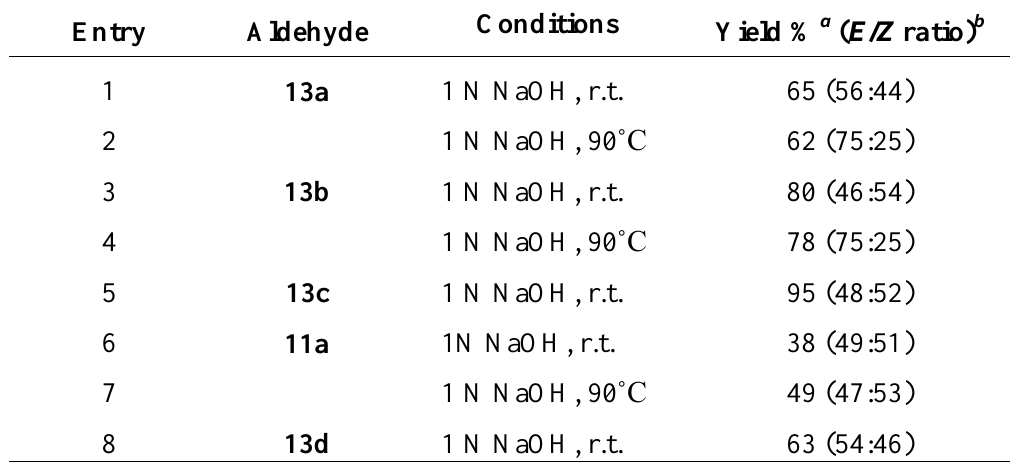
Table 2. Aqueous Wittig reactions phosphonium salt 12 and aldehydes ( 11a - 13a - d ). Entry